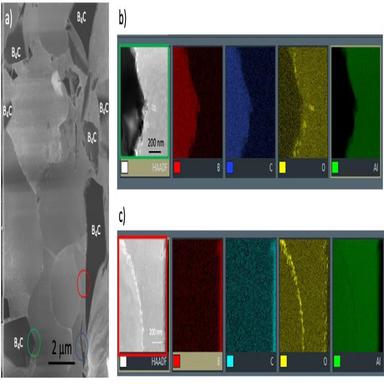
HRTEM micrographs of Al/B4C composite material; (a) typical imaging of Al/B4C composite slide (b) HAADF imaging and B, C, O, and Al EDX maps at Al-B4C interface (c) HAADF imaging and B, C, O and Al EDX maps at Al-Al grain boundaries.